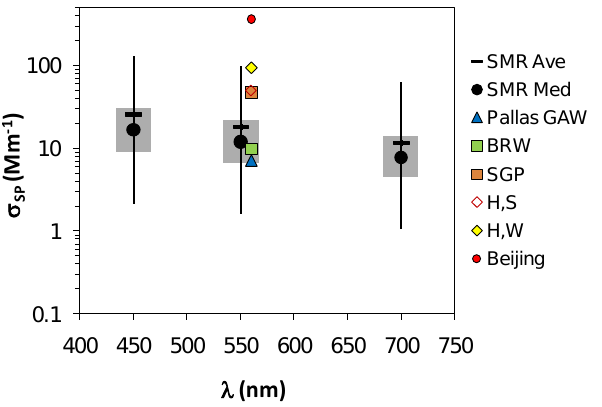
Fig. 4. Averages, medians, 1st, 25th, 75th, and 99thpercentiles of hourly-averaged σ SP at Hyyti¨al¨a (SMR) in October 2006– May 2009. For comparison the average σ SP (550nm) measured at the Pallas GAW station in Finnish Lapland (Aaltonen et al., 2006), Barrow in Alaska (BRW), Southern Great Plains in Okla- homa (SGP) (Delene and Ogren, 2002), Hungarian plain in summer (H, S) and in winter (H, W) (M´esz´aros et al., 1998) and in Beijing, China (Garland et al., 2009) are presented.